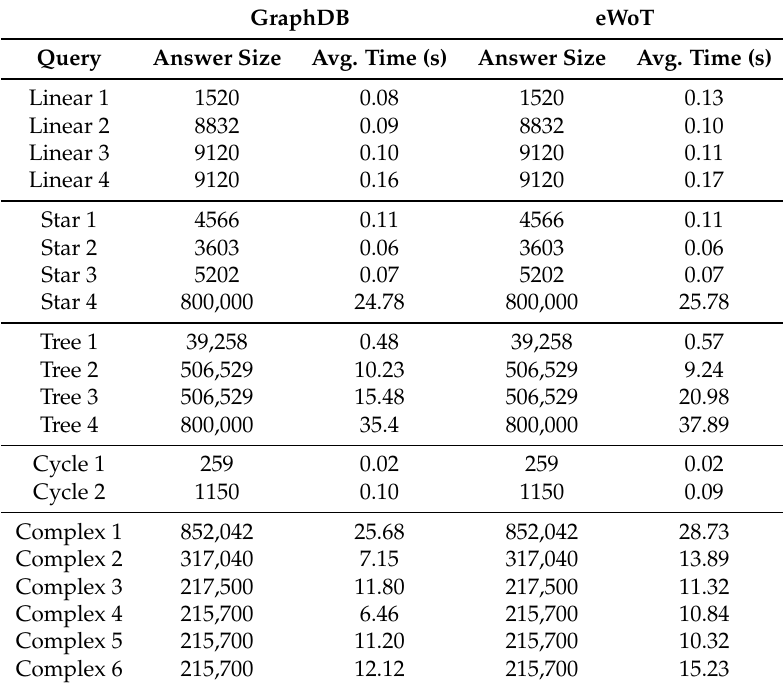
Table 2. Effectiveness: averaged results obtained by a triple store and our client plus the statistical significance of their differences.